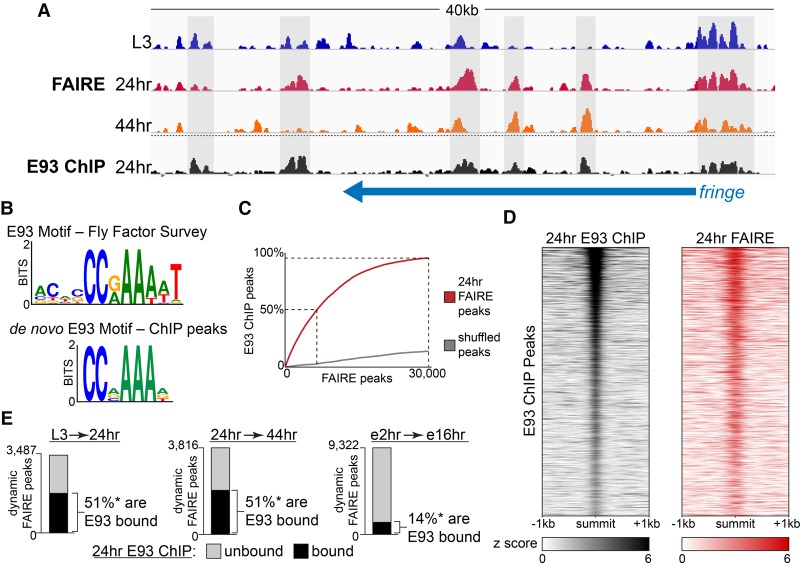
E93 binds temporally dynamic open chromatin. (A) Browser shot from the fringe locus showing FAIRE-seq and E93 ChIP-seq signals (Z-score) from pupal wings. (B) Position weight matrices comparing the E93 motif discovered in ChIP peaks with the known E93 motif. (C) Cumulative distribution plot of E93 ChIP peak overlap with 24-h FAIRE peaks (red line) relative to randomly shuffled FAIRE peaks (gray line). (D) Heat maps plotting E93 ChIP-seq and FAIRE-seq signals (Z-score) in E93 ChIP peaks from 24-h pupal wings. (E) Stacked bar plots showing the fraction of temporally dynamic FAIRE peaks (opening and closing) that overlap an E93 ChIP peak. (*) Overlap P-value <2.2 × 10−16 relative to temporally dynamic FAIRE peaks in embryos, Fisher's exact test.